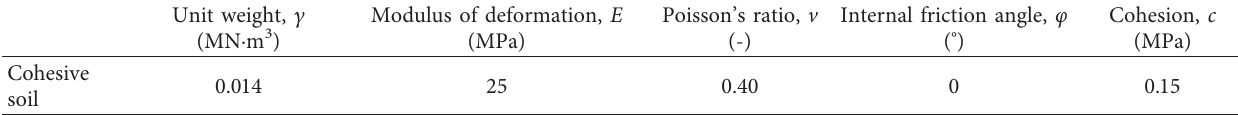
Table 2: Physical and mechanical properties of soil.